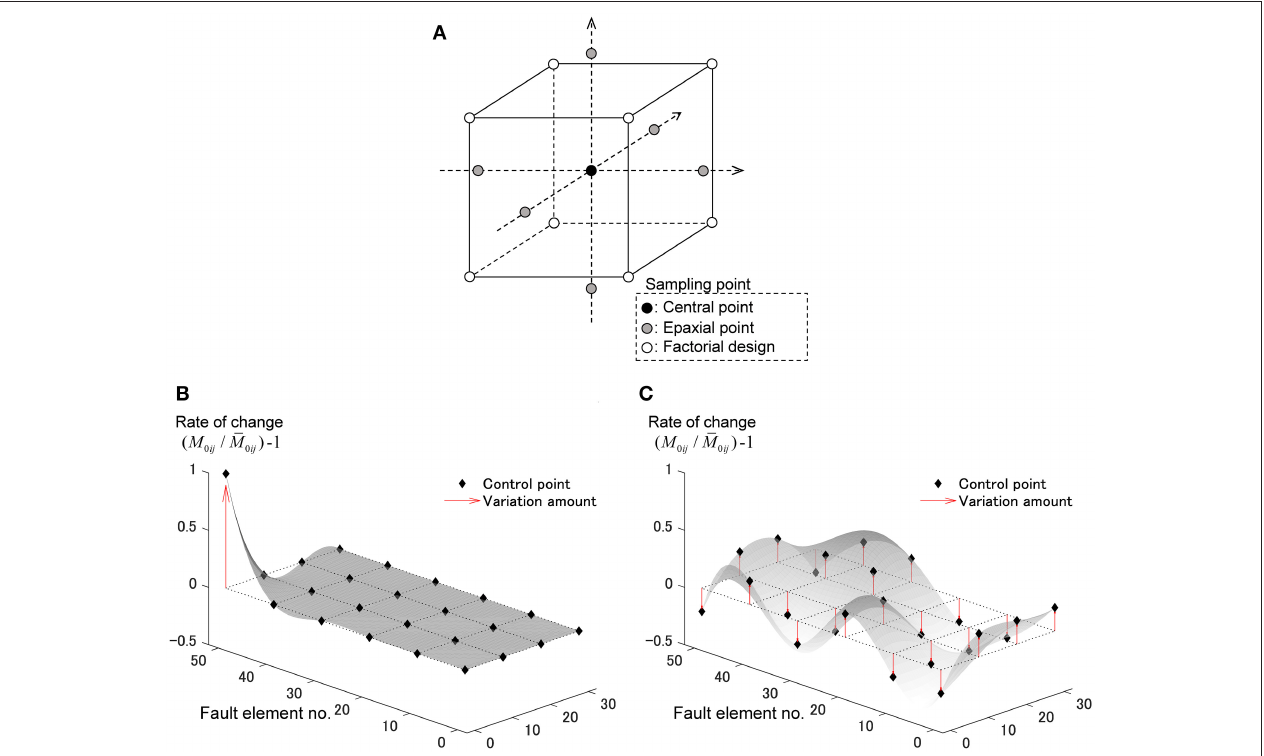
FIGURE 2 | Expression of variability in seismic moment allocated to fault element for response surface method. (A) Schematic diagram of three-dimensional Central Composite Design (CCD). (B) Example of epaxial point. (C) Example of factorial design.